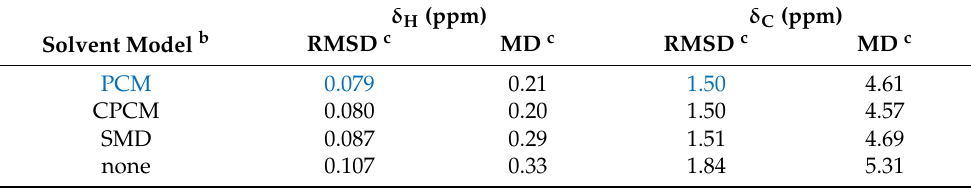
Table 6. Impact of implicit solvent model on chemical shift predictions a